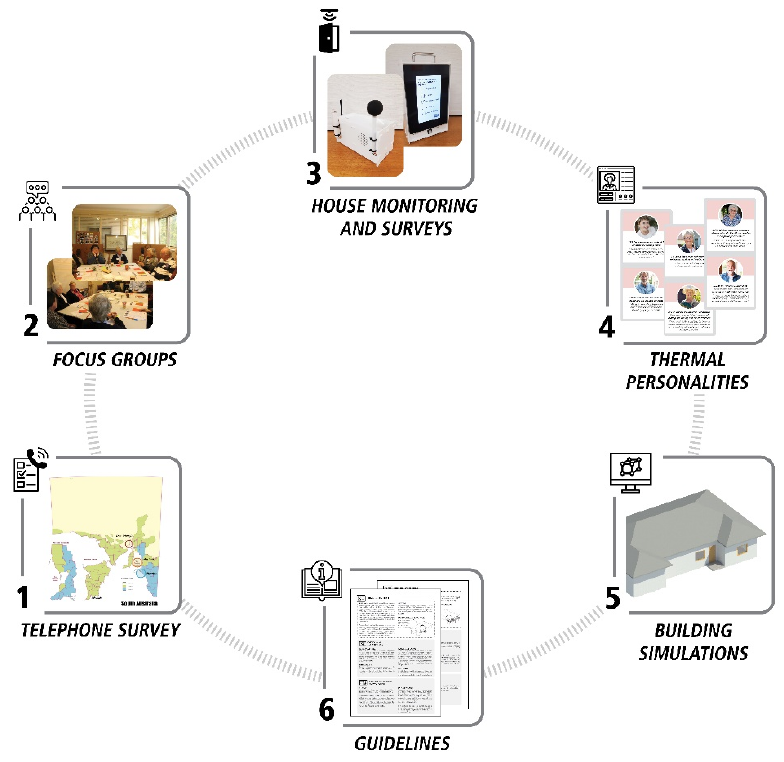
Figure 1. Stages of the study on “Improving thermal environment of housing for older Australians”.